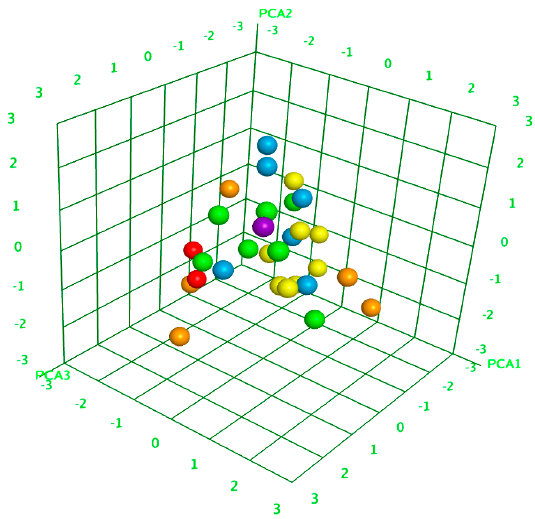
Figure 5. The 3D scatter plot of three selected principle components (PCA1, PCA2, and PCA3), each point corresponds to a molecule and is colored according to its activity.